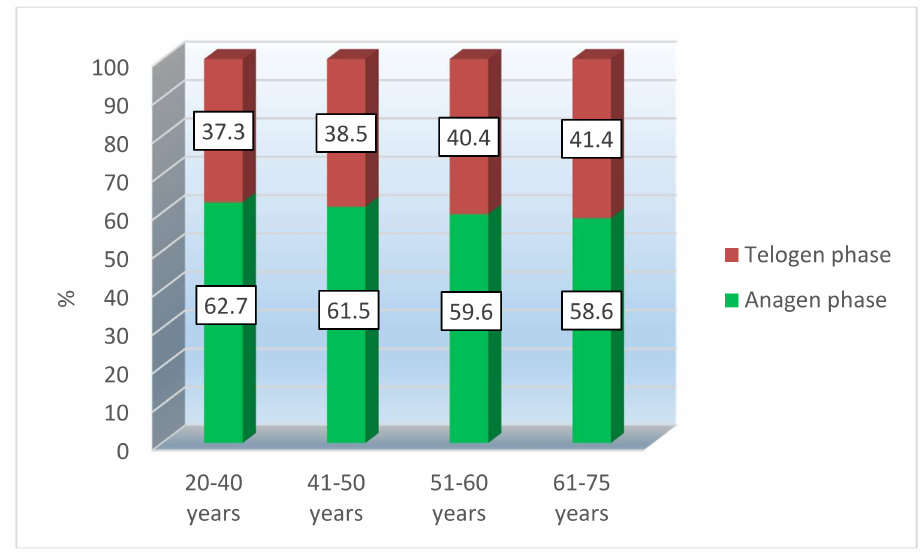
Figure 3. Mean basal values of percentage of hair in anagen/telogen phase as function of the group